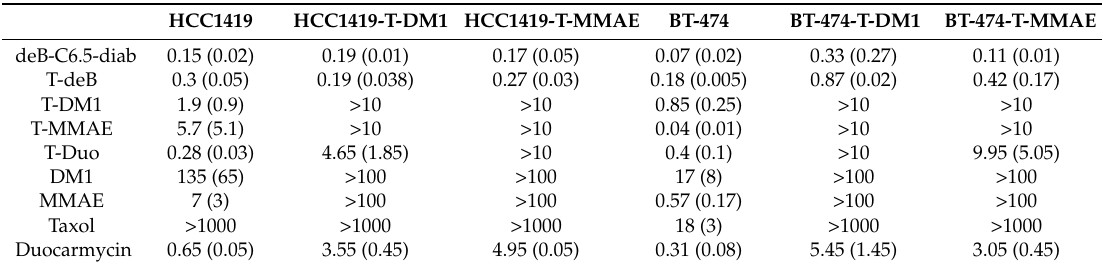
Table 2. Comparison of potency against untreated or T-DM1 or T-MMAE treated BT-474 or HCC1419 cells. HCC1419 HCC1419-T-DM1 HCC1419-T-MMAE BT-474 BT-474-T-DM1 BT-474-T-MMAE deB-C6.5-diab